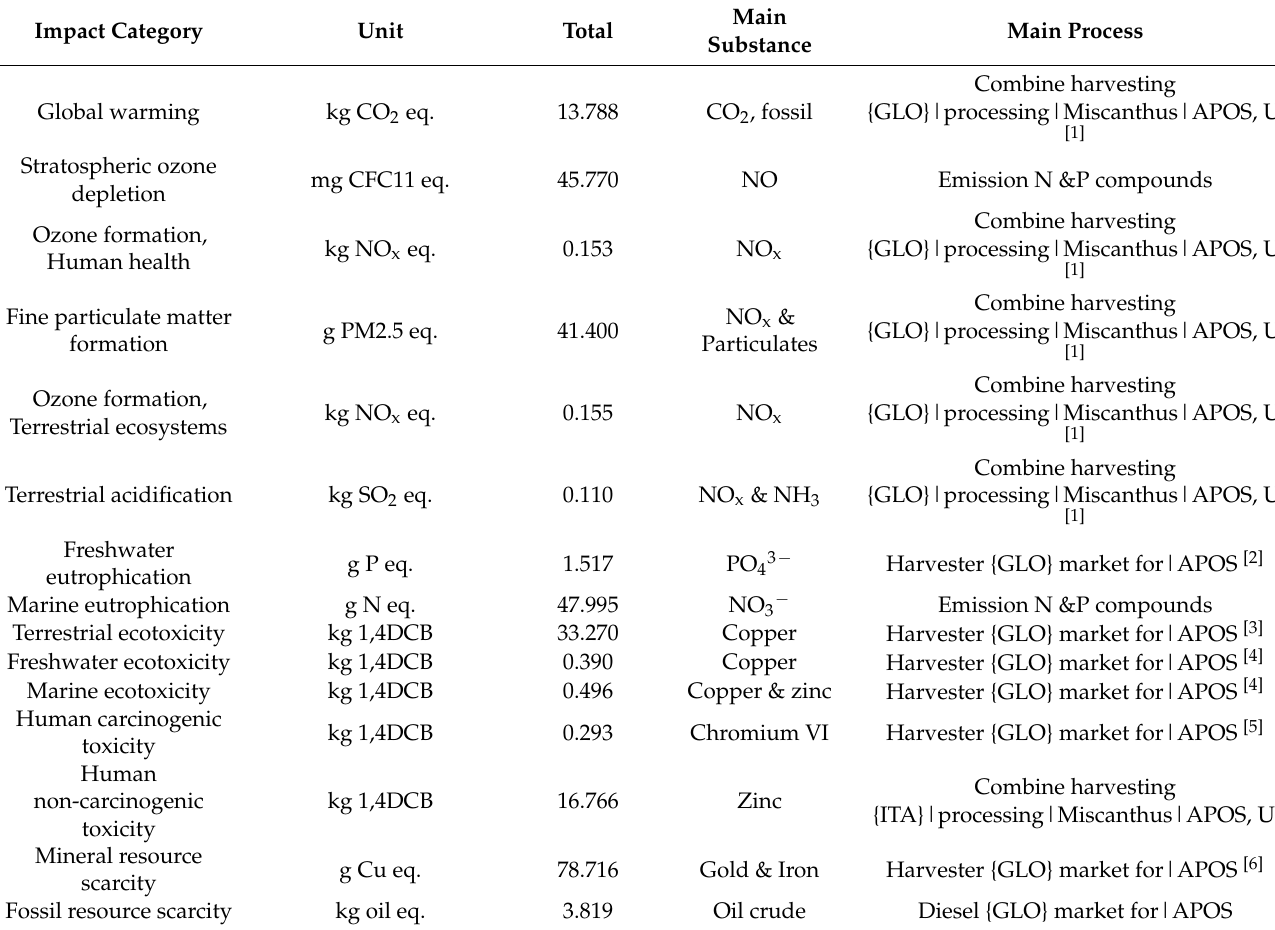
Table 5. Environmental impact of 1 ton of miscanthus